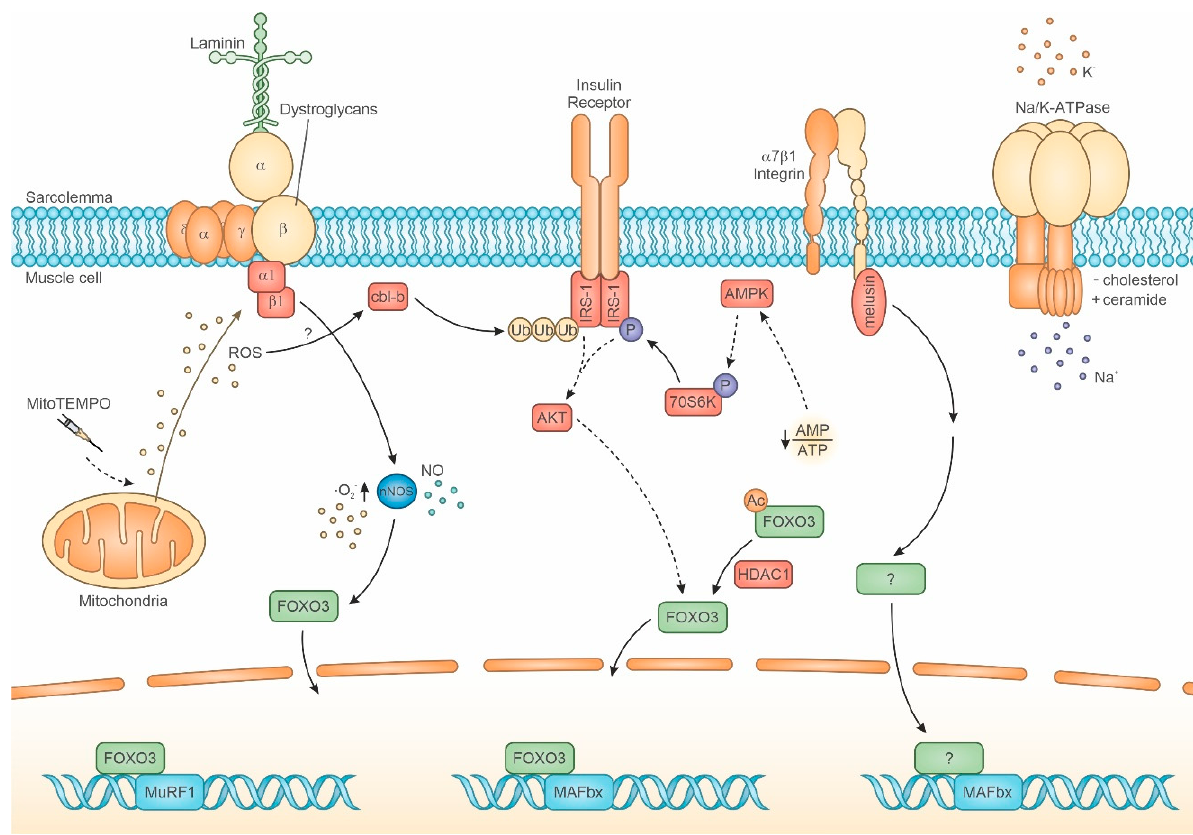
Figure 3. Signaling pathways activated after a 6–12 h bout of muscle unloading in costameres. Continuous lines indicate stimulatory effects, while discontinuous lines indicate inhibitory effects. Cbl-b = Casitas B-lineage lymphoma-b ubiquitin ligase; Ub = ubiquitin; nNOS = neuronal nitric oxide synthase; FOXO3 = forkhead box O3; MuRF1 = muscle RING-finger protein-1; MAFbx = muscle atrophy F-box; HDAC1 = histone deacetylase 1; Ac = acetylation; IRS-1 = insulin receptor substrate-1; 70S6K = Ribosomal protein S6 kinase p70; P = phosphorylation; AMPK = AMP-activated protein